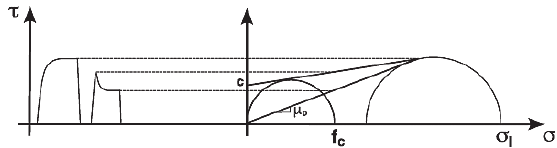
Fig. 3 Yield locus construction from shear experiment data. Mohr circles for the determination of f and σ I .